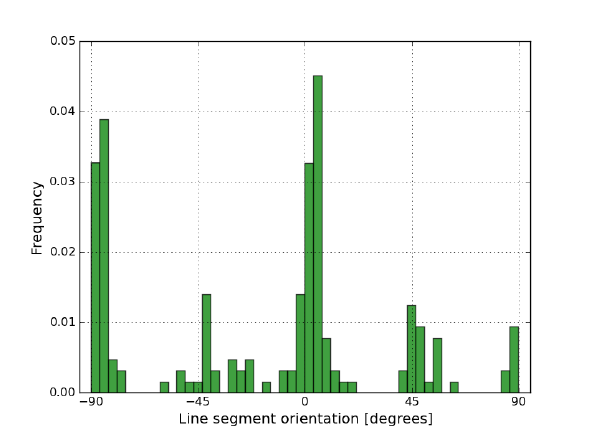
Figure 1: Distribution of line segment angles in a rectangular building (where 0 ◦ corresponds to an horizontal orientation)